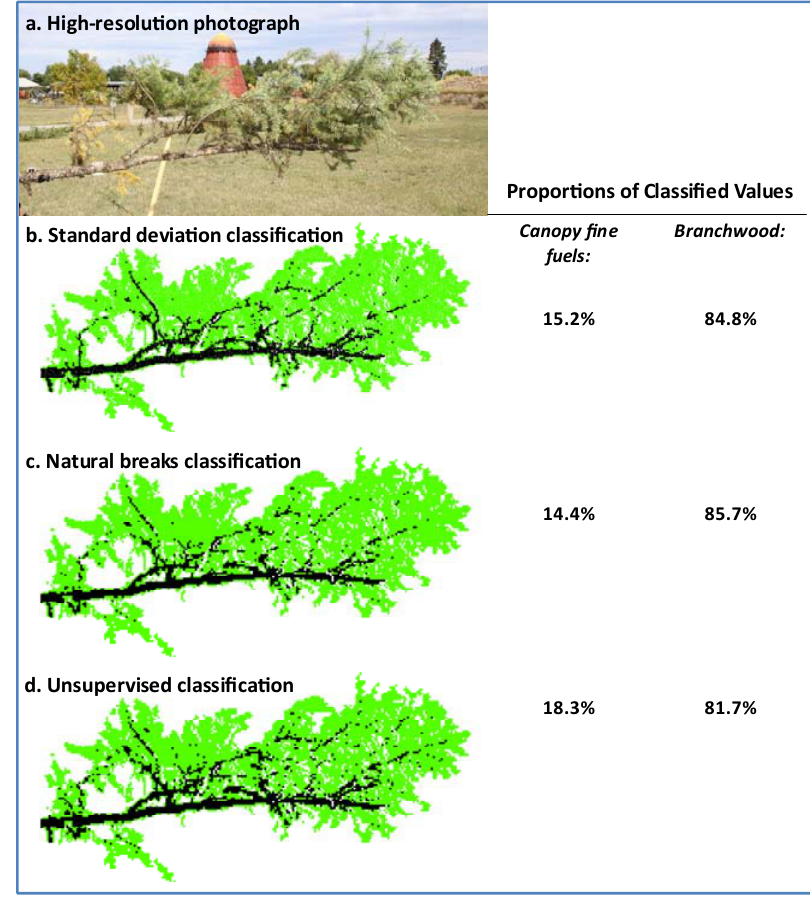
Figure 11. Classification of a Douglas-fir branch into intensity-based size class categories using different methods. For (a), (b), and (c), canopy fine fuel returns are shown in green and branchwood returns are shown in black. (a) High-resolution photograph of branch sample #3 in the 0° position. (b) Classified image edited to branch extent. Data are classified according to a threshold of 1,010, which is equal to one standard deviation above the mean for all branches scanned at 25 m and 0°. (c) Applying the Natural Breaks method with two classes in ArcMap produces a threshold equal to 1,000. (d) Unsupervised classification (ERDAS ISODATA, iteration threshold of 10) results in a similar